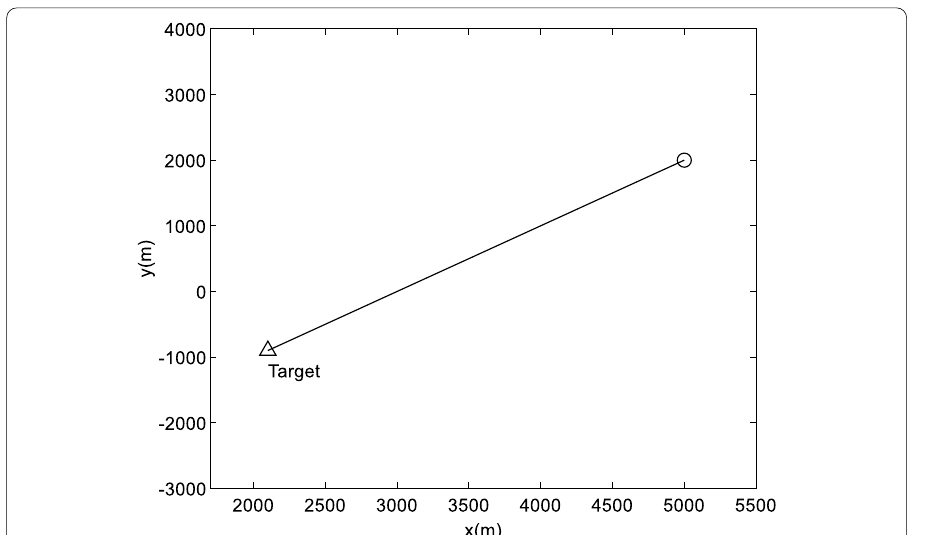
Fig. 4 Single target trajectory and start/stop position is shown with with ◦ /